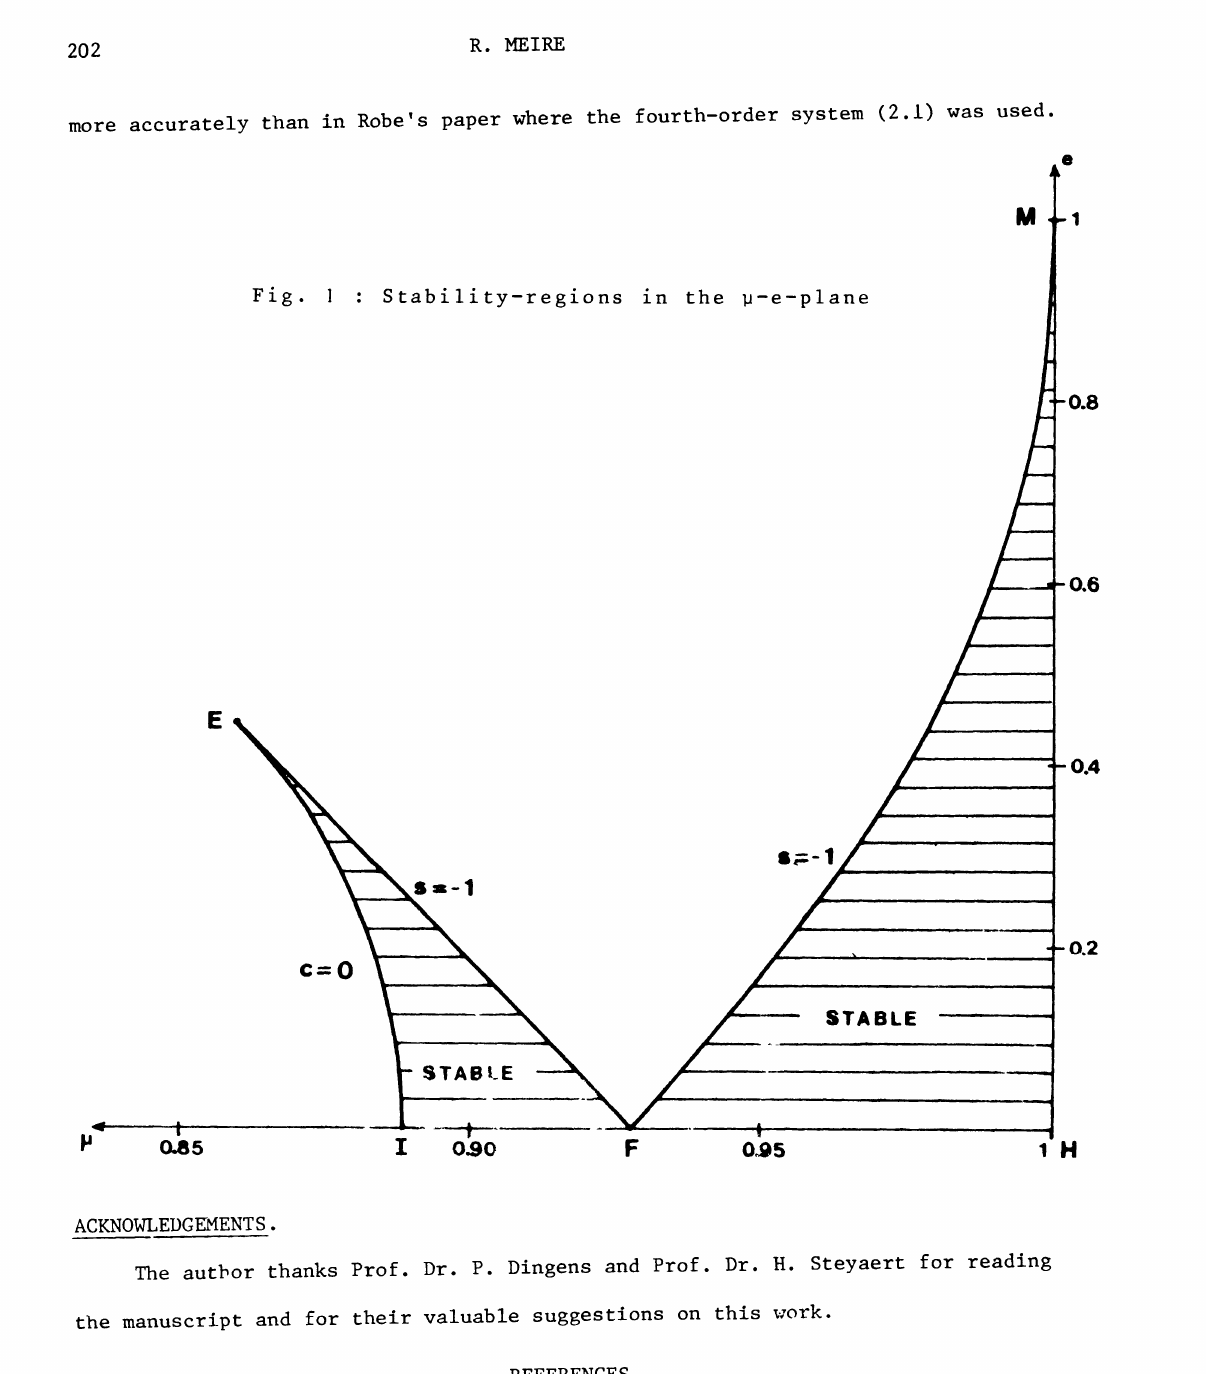
Fig. Stability-regions in the -e-plane